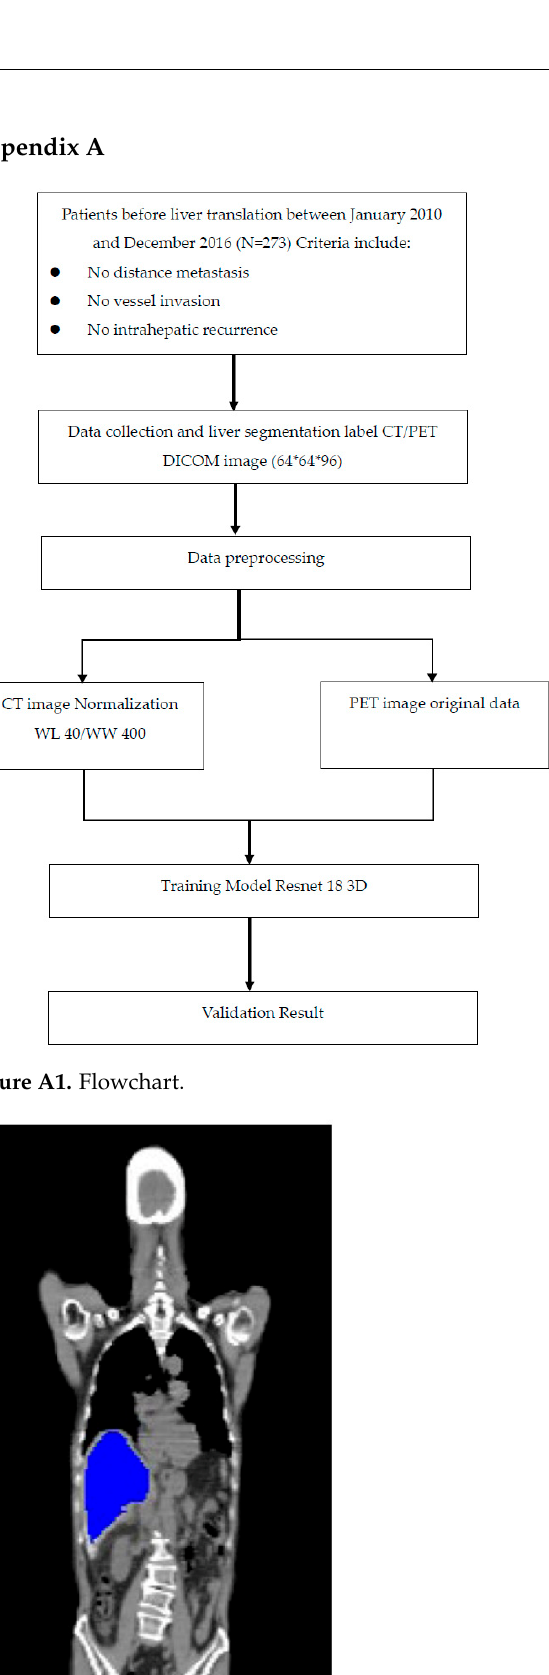
Figure A3. Only the CT and PET information of 64 × 64 × 96 pixels within the liver is retained. Figure A4. The area under the curve of 0.807 for the PET-CT base.